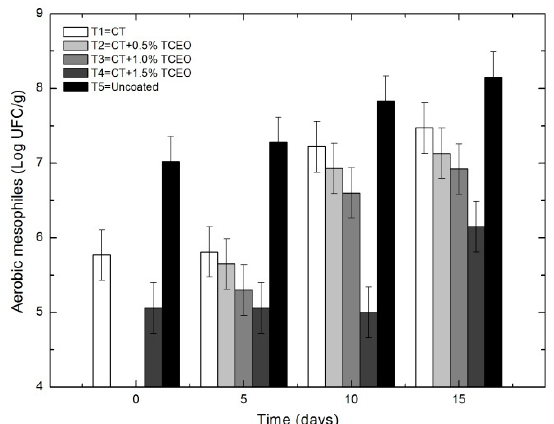
Figure 9. Effect of treatments on the concentration of aerobic mesophilic in strawberries with chitosan (CT) and treatments of oil (TCEO): T1 = CT, T2 = CT + 0.5% of TCEO, T3 = CT + 1.0% of TCEO, T4 = CT + 1.5% TCEO, and T5 = uncoated. Mean values and intervals of Fisher’s LSD of 95% according to the ANOVA test.